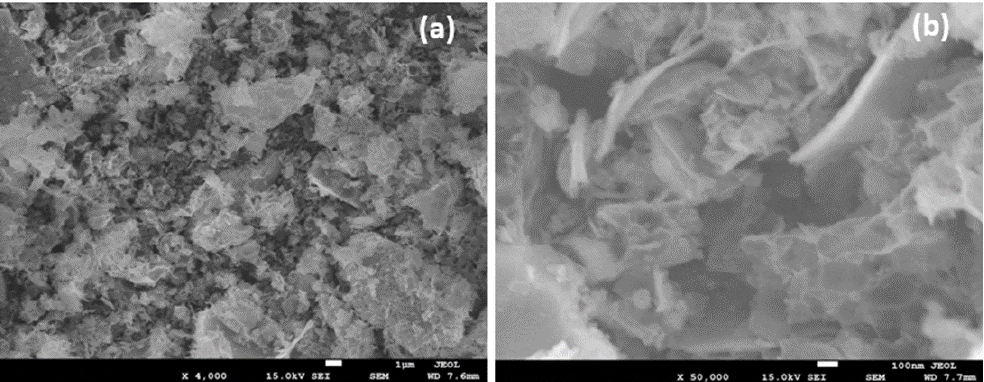
Figure 3. SEM images of CeO 2 /NiO nanocomposite at ( a ) 4000× and ( b ) 50,000×.